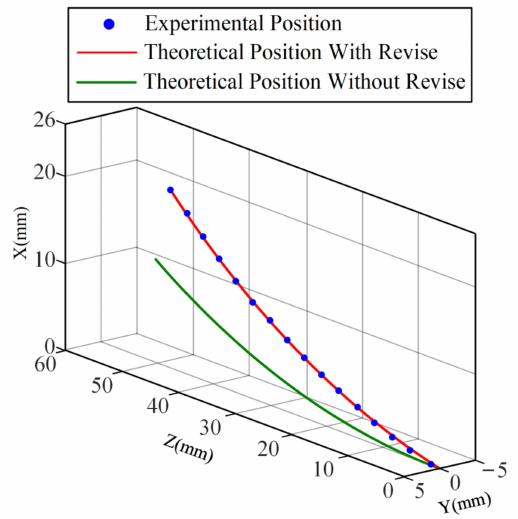
Figure 7. Prediction results of different models for the tip position of the feed